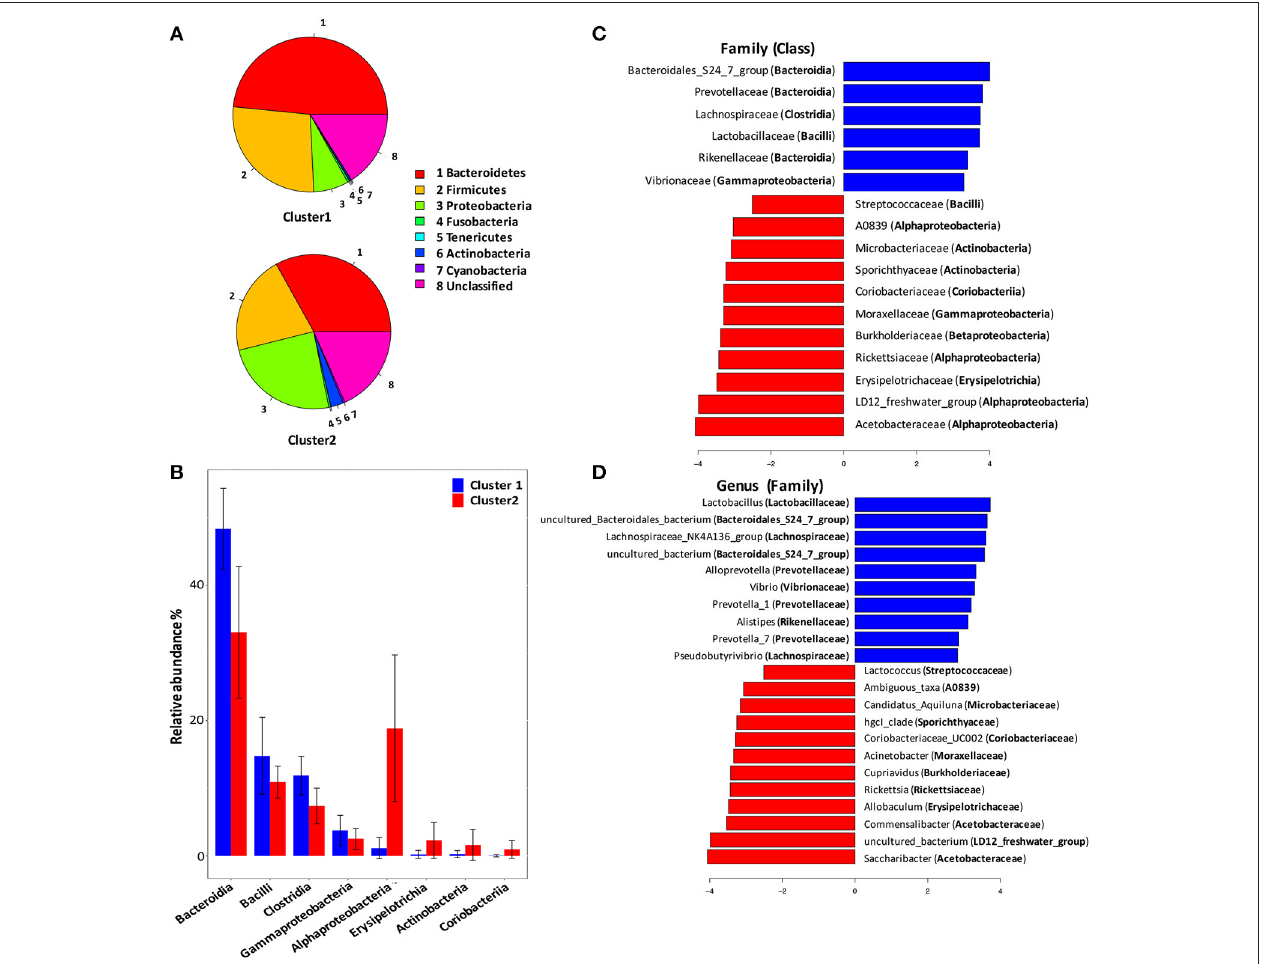
FIGURE 2 | Compositional analysis of ascitic microbial clusters. (A) Pie chart comparison of bacterial phyla represented in two clusters (upper: Cluster 1, lower: Cluster 2). (B) Histograms showing differentially enriched bacterial classes between Cluster 1 and Cluster 2. Blue histograms, Cluster 1; red histograms, Cluster 2. (C) . LEfSe analysis revealed differentially enriched bacterial families associated either with Cluster 1 (blue) or Cluster 2 (red). (D) LEfSe analysis revealed differentially enriched bacterial genus associated either with Cluster 1 (blue) or Cluster 2